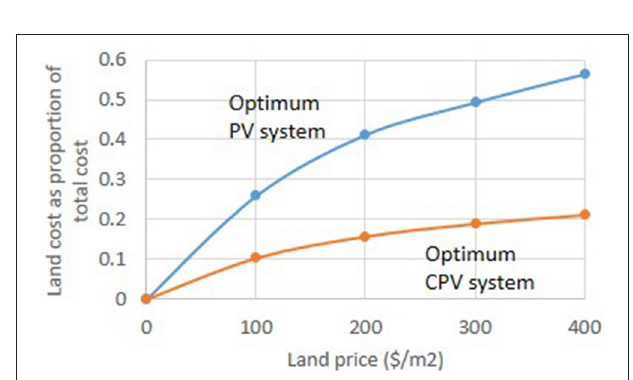
FIGURE 10 | Land cost as a proportion of total project cost for the optimal battery sizes from Figure 9